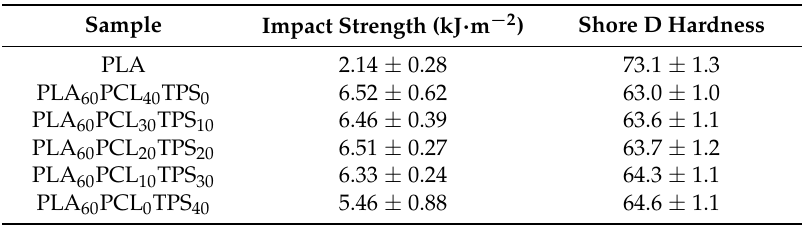
Table 2. Impact strength and Shore D hardness of the polylactide (PLA), poly( ε -caprolactone) (PCL), and thermoplastic starch (TPS) blend